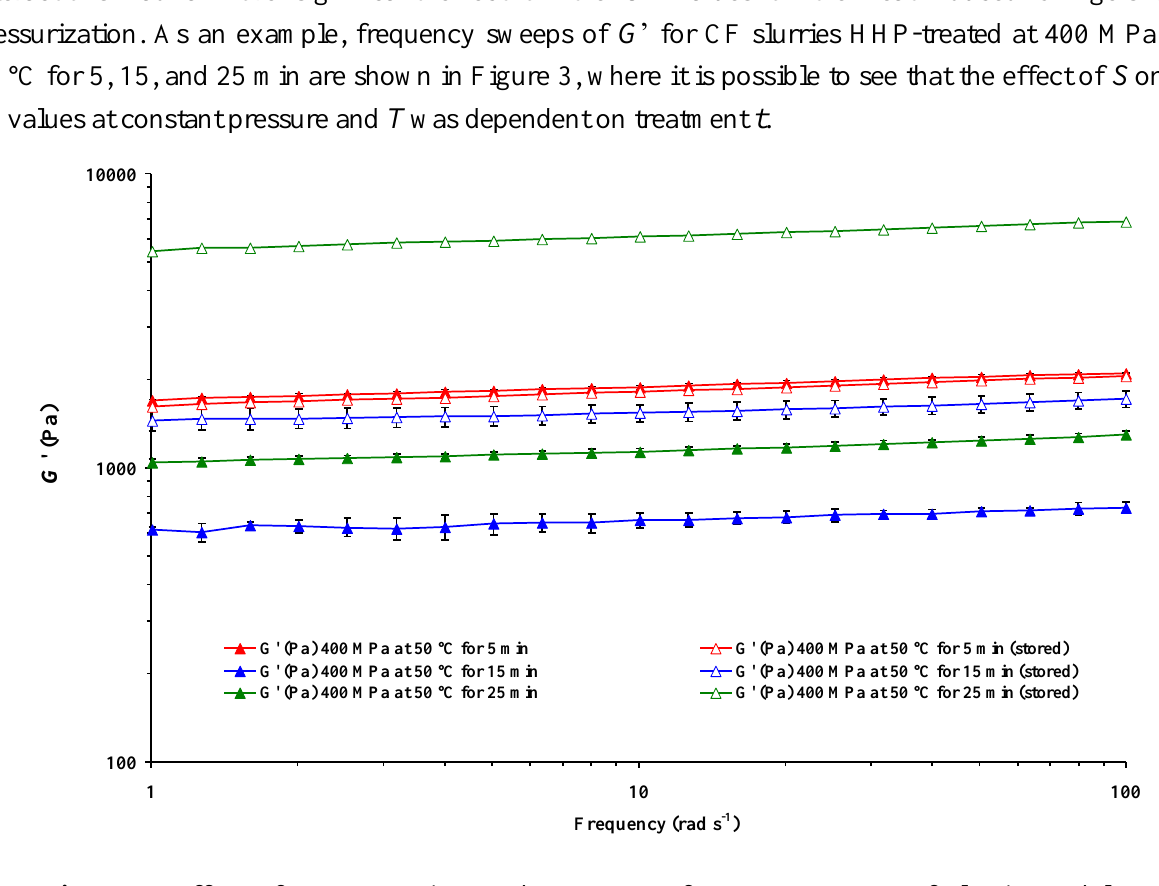
Figure 3. Effect of treatment time and storage on frequency sweeps of elastic modulus ( G ’) of heat-induced chickpea flour gel pressurized (400 MPa at 50 °C) at 25 °C. Mean values of six measurements ± error